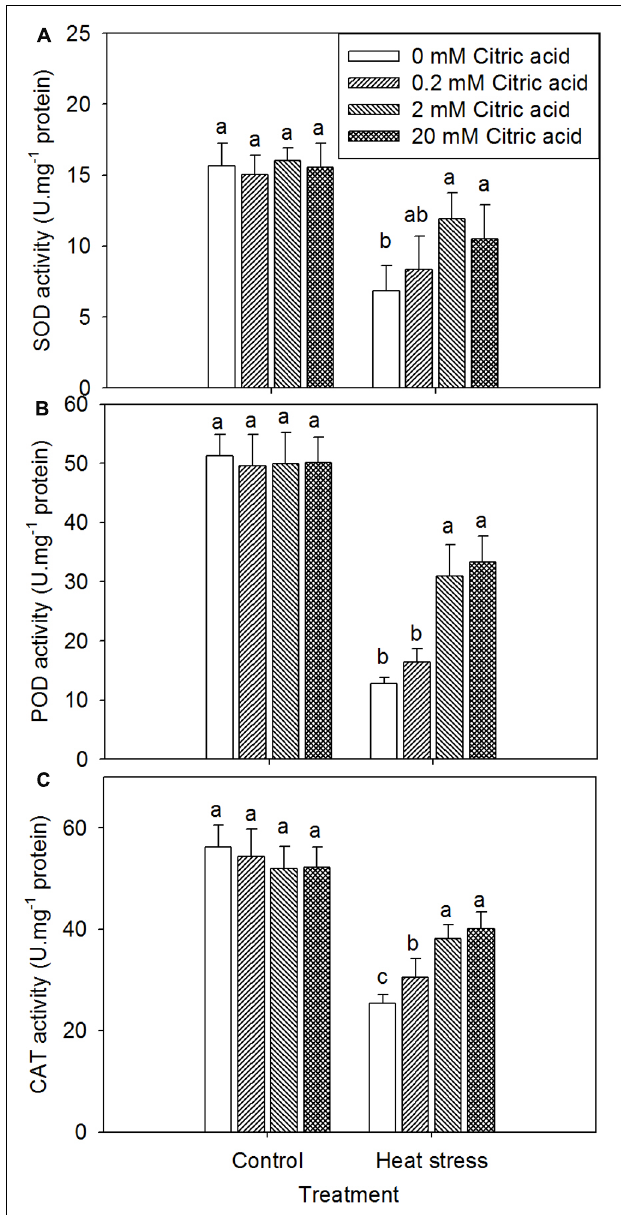
FIGURE 6 | Effect of exogenous citric acid on SOD (A), POD (B) and CAT (C) under control (25/20 ± 0.5 ◦ C, day/night) and heat stressed (35/30 ± 0.5 ◦ C, day/night) conditions in tall fescue. Vertical bars on the top provide the standard deviation ( n = 4), and bars with the same letter indicate no significant difference at P < 0.05 for the comparison of different citric acid concentrations under control or heat